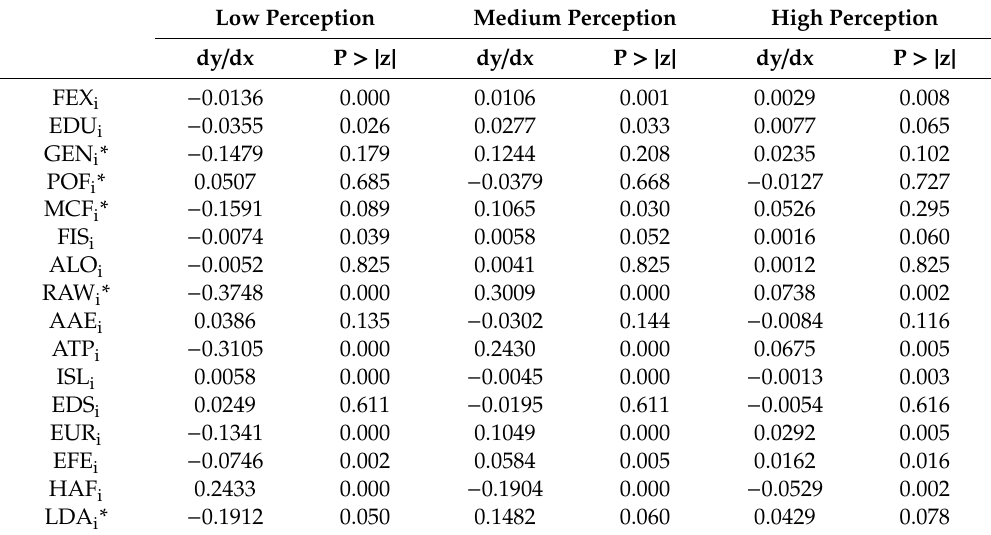
Table 7. Marginal e ff ects of ordered probit models for all sample